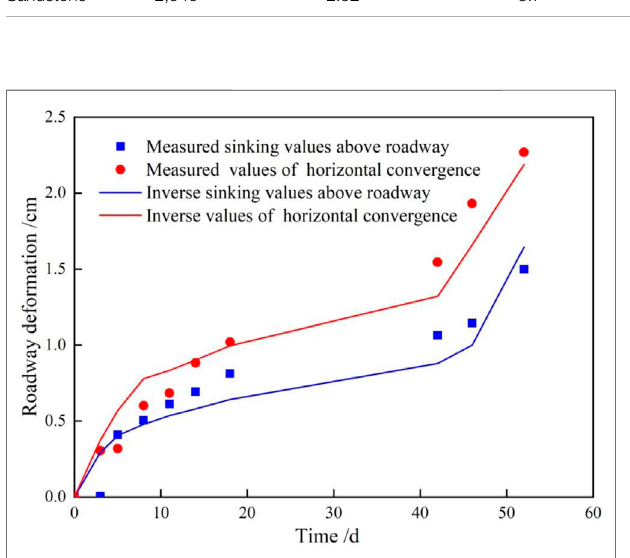
FIGURE 5 | Comparison between numerical calculation results and fi eld measurement results.